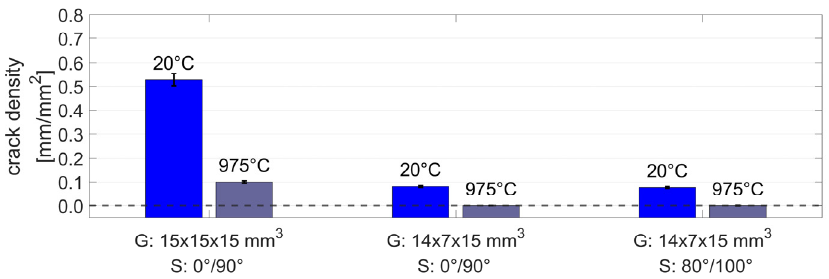
Figure 5. Crack density for different specimen geometries G, scanning strategies S, and initial substrate temperatures. Error bars represent 5% measurement uncertainty.